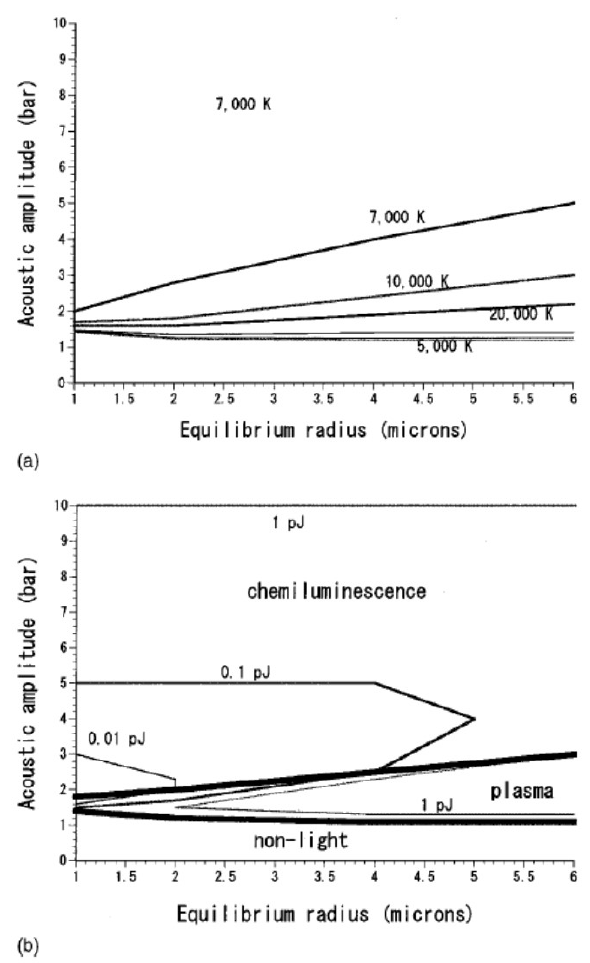
Figure 10. Results of numerical simulations of bubble pulsations for various acoustic amplitudes and equilibrium bubble radii for an argon bubble in 5 ◦ C water irradiated by 20 kHz ultrasound [34]. ( a ) The bubble temperature at the collapse. The isothermal lines are from the bottom 5000, 10,000, 20,000, 20,000, 10,000, and 7000 K. Above the isothermal line of 7000 K, the bubble temperature at the collapse is independent of acoustic amplitude and is always 7000 K. ( b ) The mechanism of the light emission. At large acoustic amplitudes chemiluminescence is relatively strong; OH* → OH + h ν , where OH* is created by the reactions O + H + M → OH* + M and OH + H + OH → OH* + H 2 O where M is the third body. At lower acoustic amplitudes emissions from plasma are dominant; electron bremsstrahlung and radiative recombination of electrons and ions. At very low acoustic amplitudes no light is emitted. The energy of the emitted light per bubble collapse is also